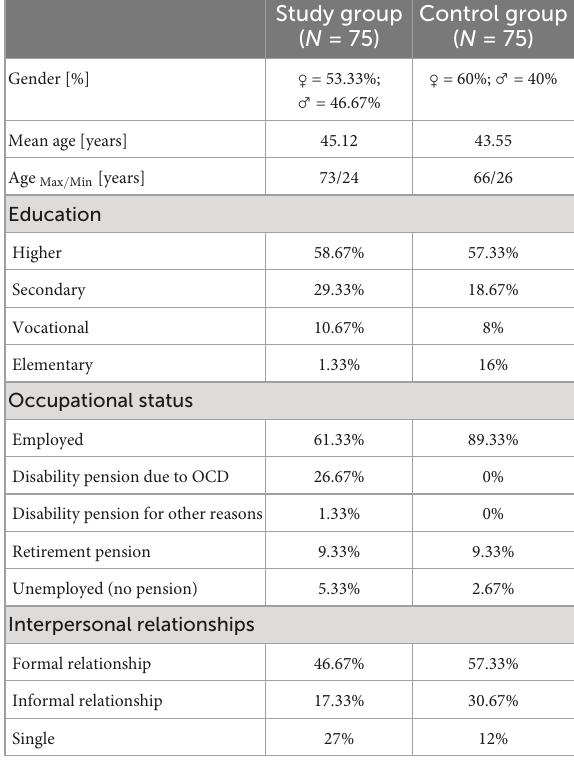
TABLE 1 Basic parameters in study vs. control